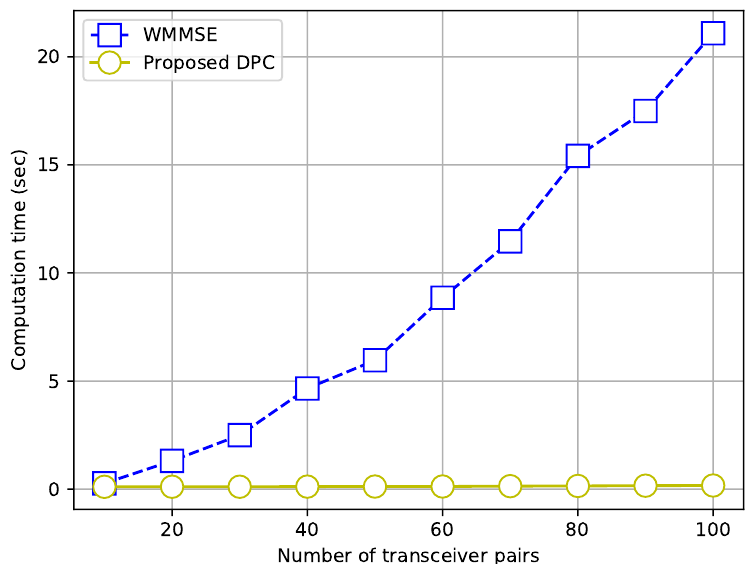
Figure 17. Computational time for the weighted minimum mean square error (WMMSE) and proposed DPC schemes according to the number of transceiver